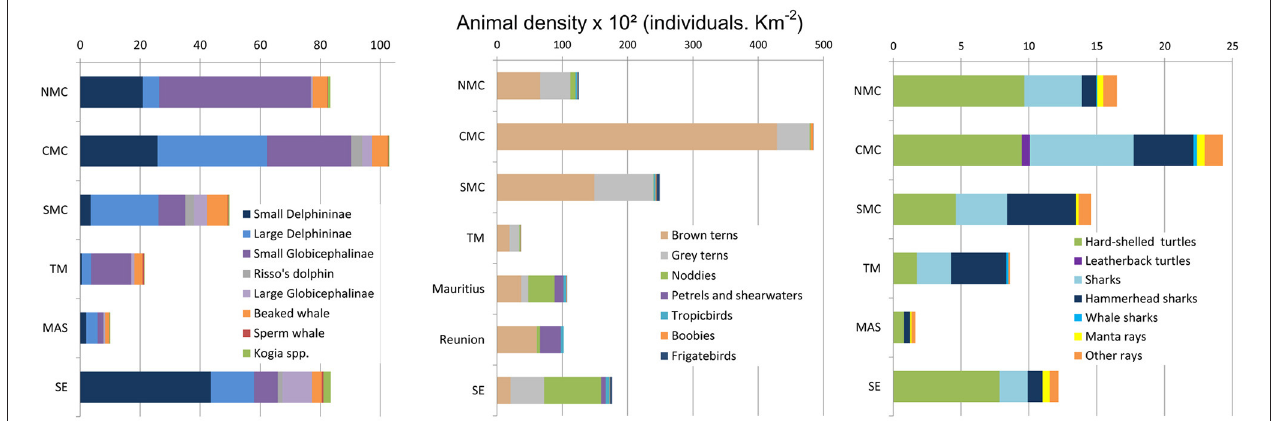
FIGURE 4 | Cummulative densities across the 6 survey blocks of the SW Indian Ocean, corrected for availability bias considering averaged proportion of time spend at surface for cetaceans, turtles, sharks and rays; seabirds were not corrected (NMC, Northern Mozambique Channel; CMC, Comoros Archipelago and the Glorioso Islands and Central Mozambique Channel; SMC, Southern Mozambique Channel; TM, east coast of Madagascar to Tromelin Island; MAS, Mascarene Islands and SE, the Seychelles